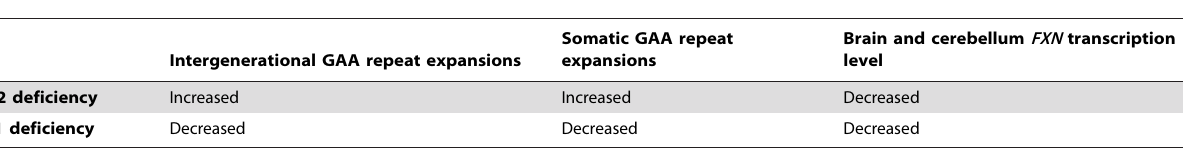
Table 3. Effect of MutL a -heterodimers on GAA repeat expansion dynamics and FXN transcription levels.